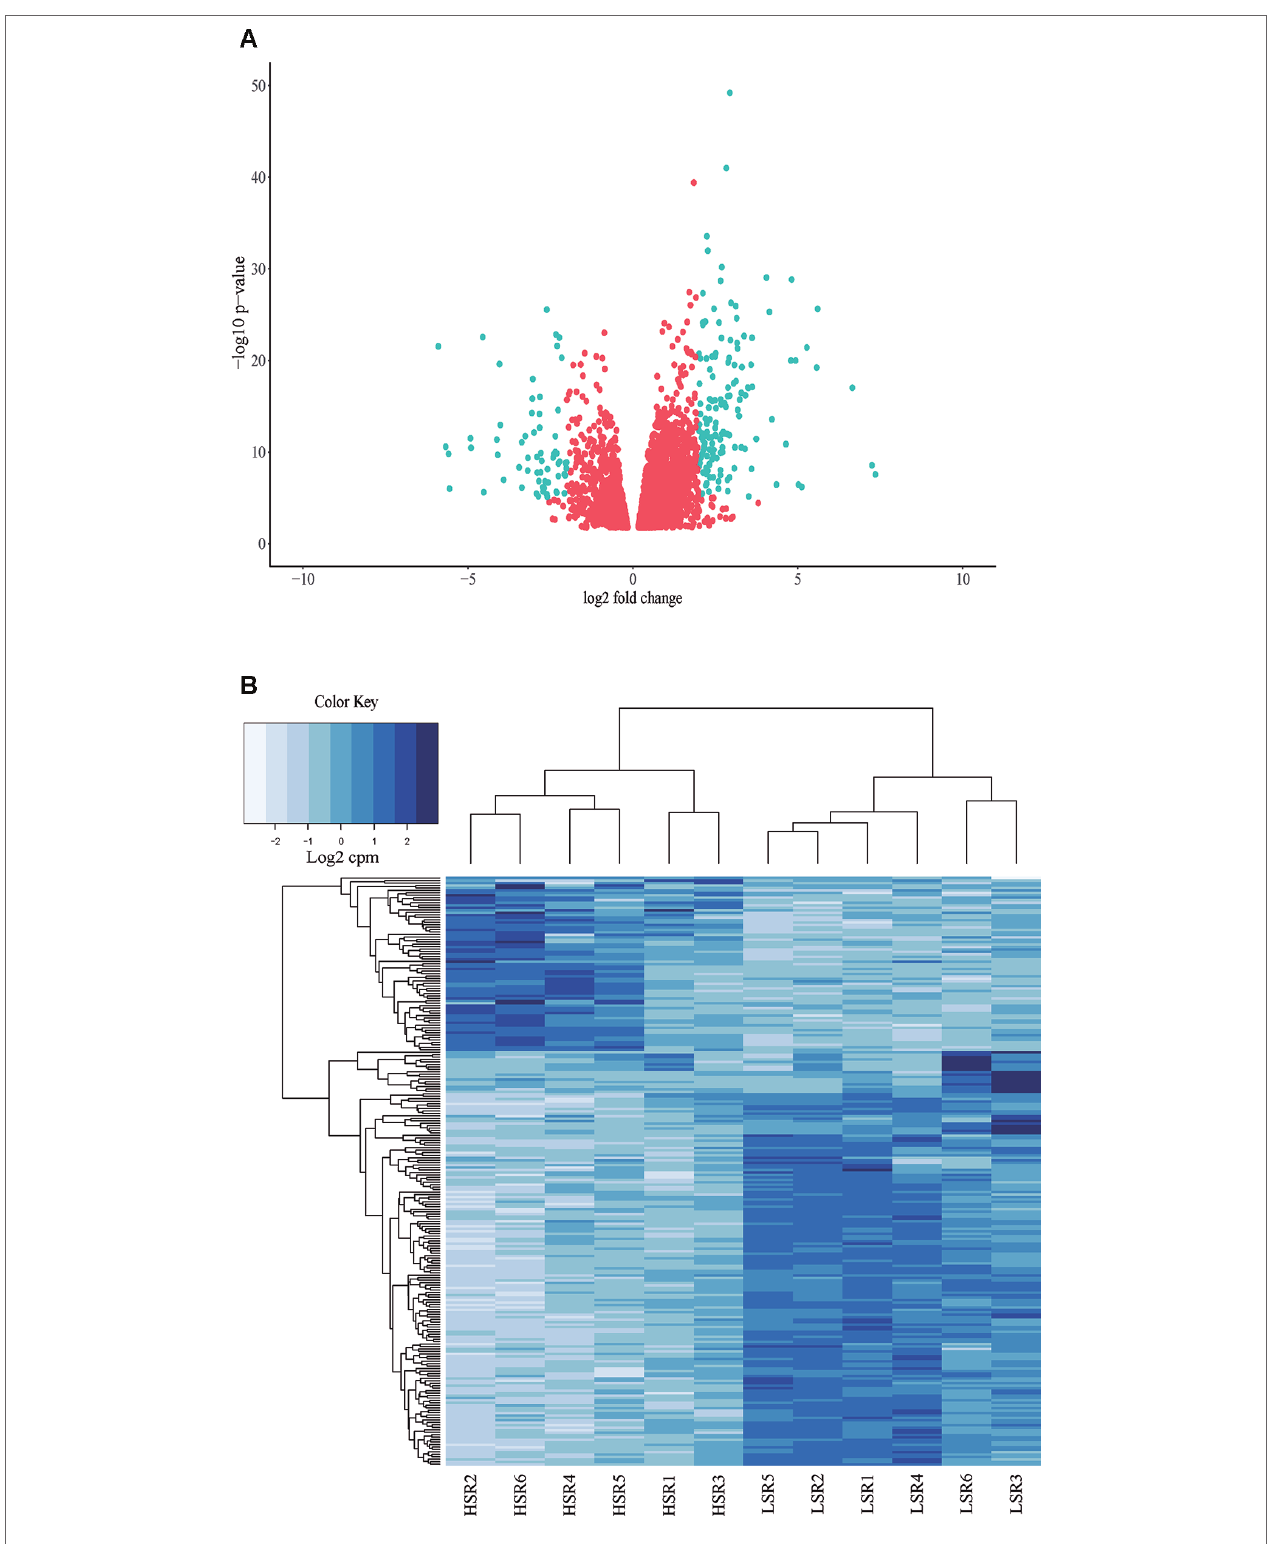
FIGURE 3 | (A) Volcano plot of the total of 5,041 differentially expressed (DE genes) identified in the comparison between LSR and HSR siblings. (B) Hierarchical clustering of the selected group of 240 DE genes (logFC > 2 or logFC < -2), corresponding to 169 DE genes up-regulated in HSR siblings and 71 DE genes up-regulated in LSR siblings. Both schemes are based on gene expression normalized values.